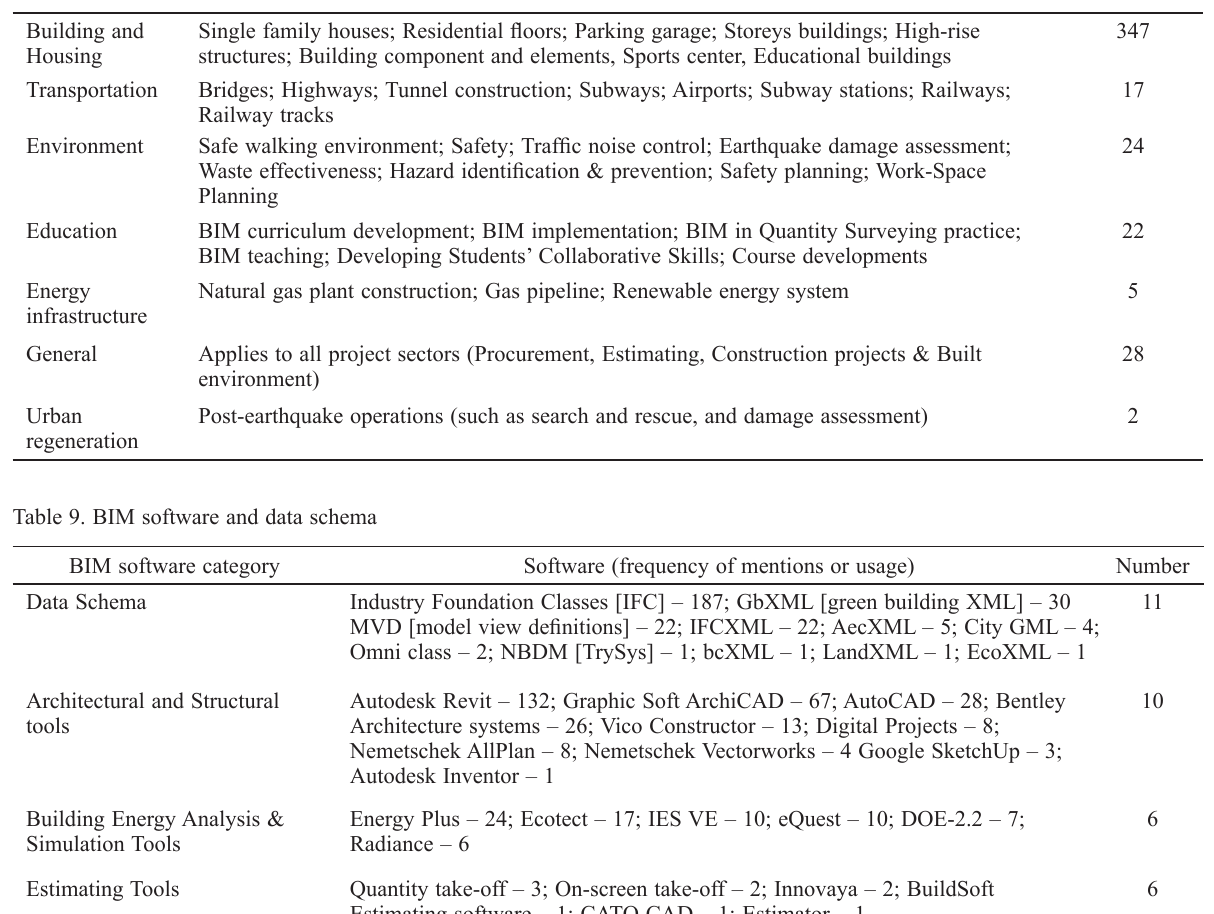
Table 8 . Articles’ project sector analysis Project Sector